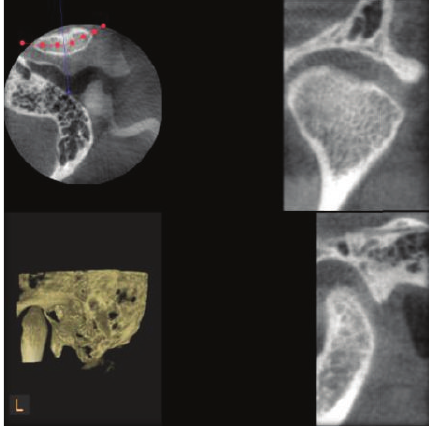
Figure 4: Erosion of condyle as seen in DVT.